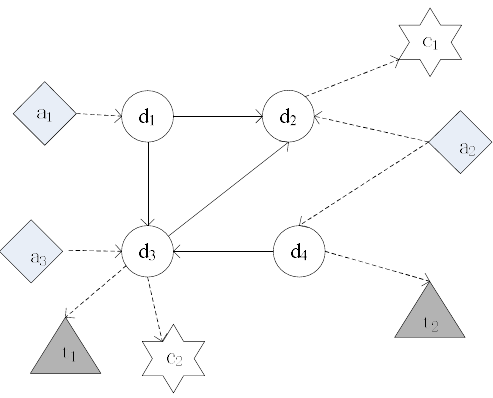
Figure 4. Star heterogeneous academic network.